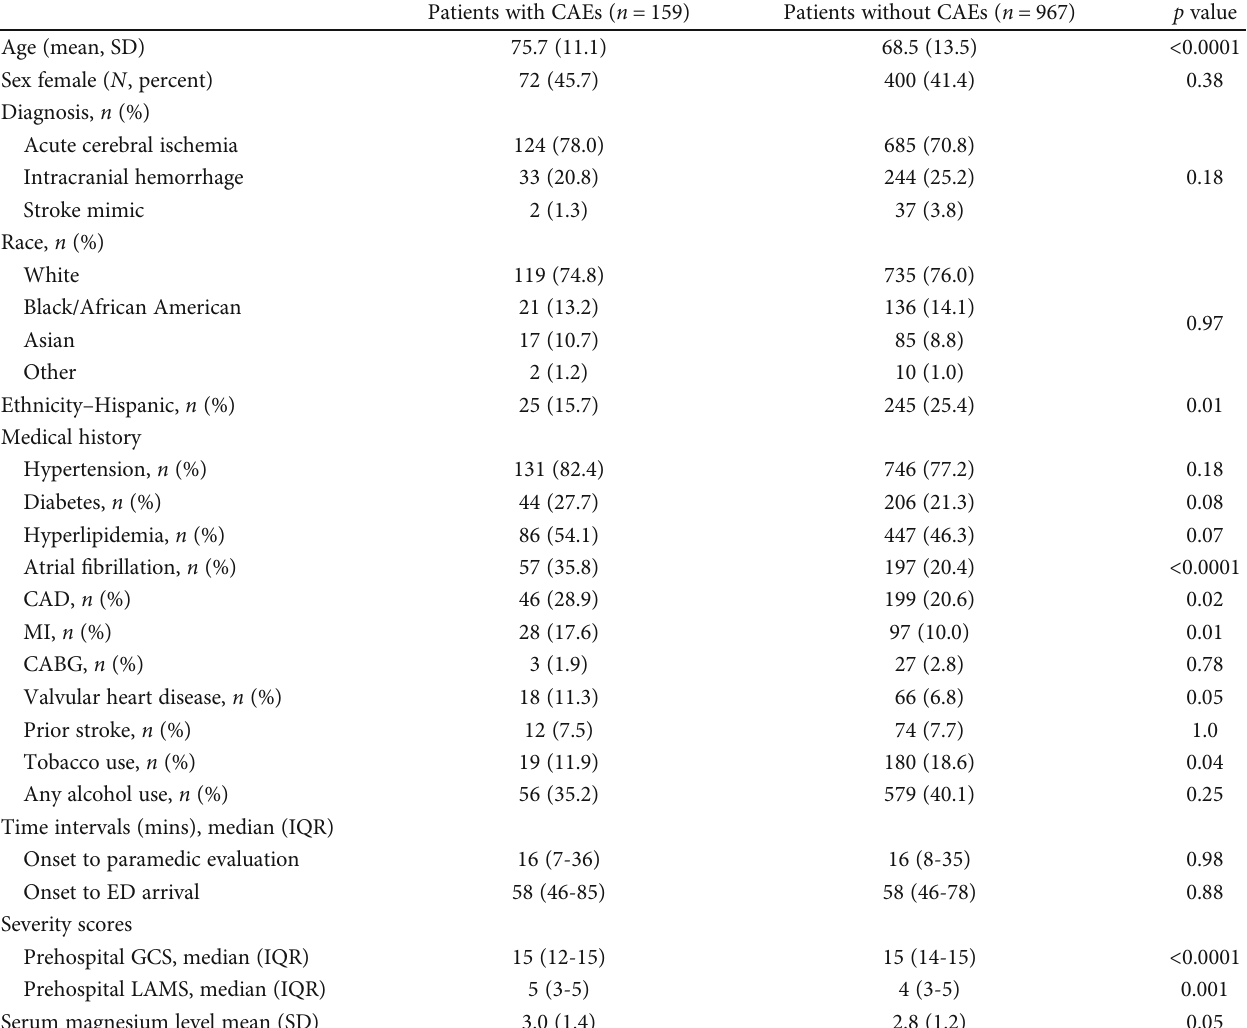
Table 4: Dichotomized demographic and clinical characteristics in stroke patients with and without CAEs.